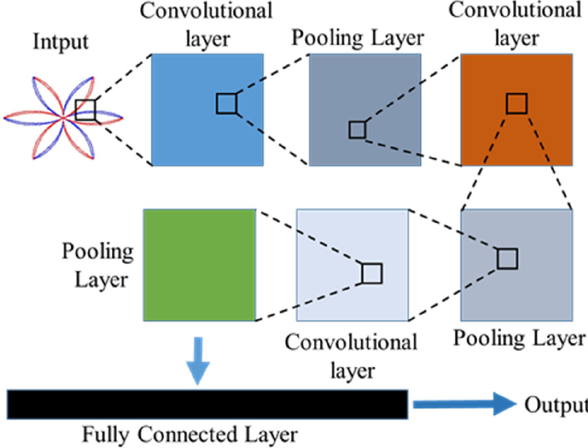
Figure 3. Schematic diagram of the CNN operation .